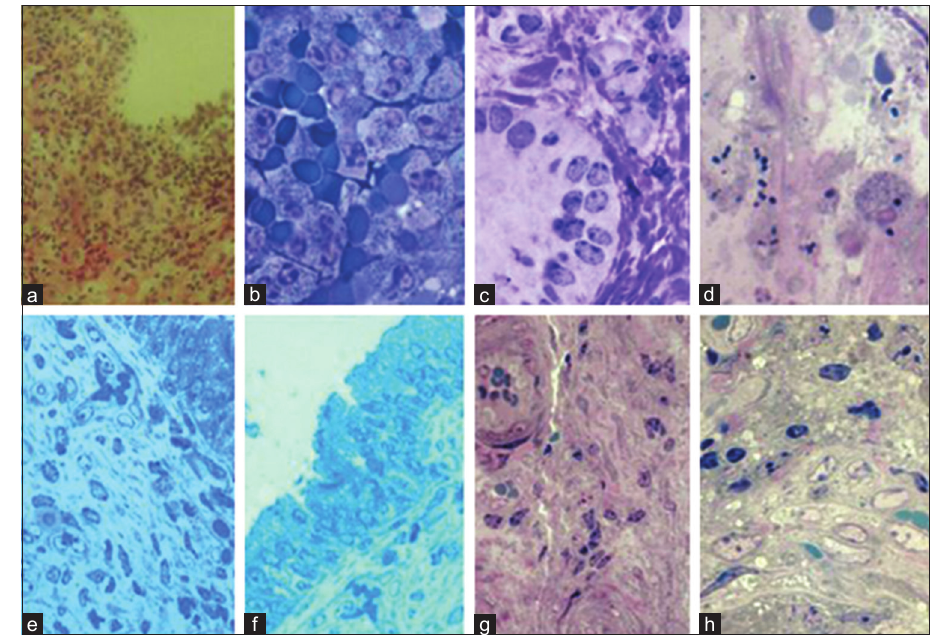
Figure-1: Histological changes in the mucous membrane of the uterus in case of acute postpartum purulent-catarrhal endometritis in cows: (a) Necrobiosis of the epithelial layer of the mucosa, (b) cellular infiltration with the shaped blood elements in the functional layer, (c) swelling of the cells of the uterine gland, (d) single microbes on the mucosa, (e) swelling of the stroma of the functional layer of the endometrium, (f) swelling of the epithelial layer of the endometrial mucosa, (g) endothelial dystrophy of vessels, and (h) swelling of fibroblastic and lymphoid cells. Color: (a) Hematoxylin-eosin, (b-d, g, h) Azur-2 in combination with basic fuchsin, and (e and f) toluidine blue. Magnification: (a) 320, (b-d and e) 800, (f) 700, (g) 400, and (h)